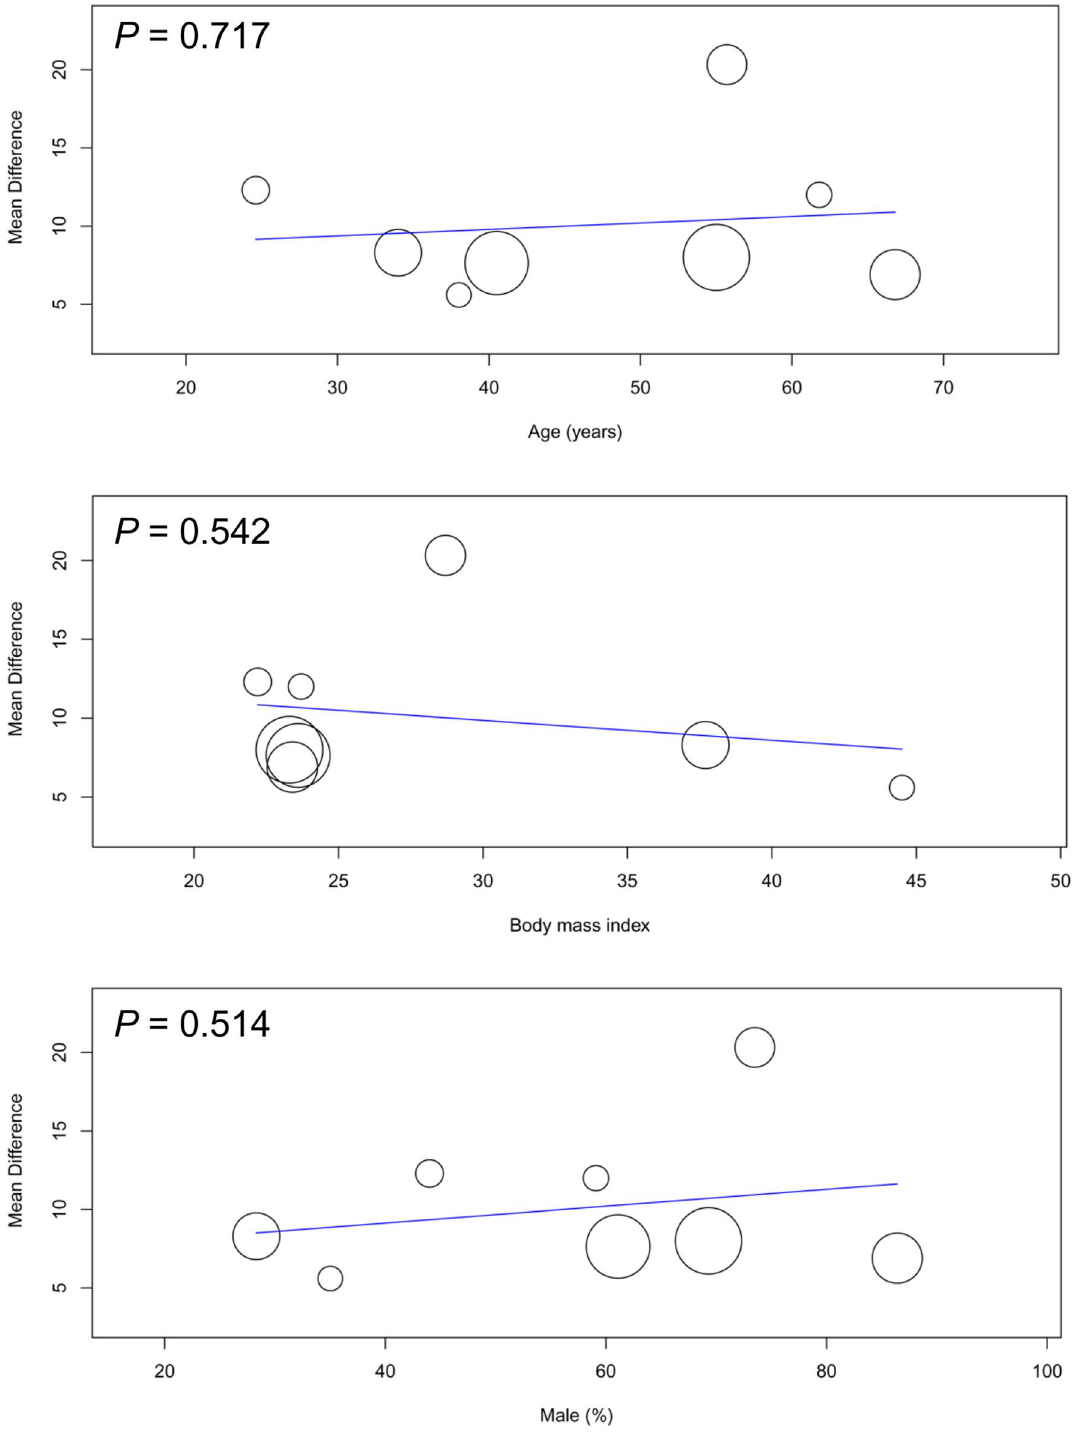
Figure 7. Meta-regression plot showing the association of patient characteristics (i.e., age, prevalence of male gender, and body mass index) with the mean difference in cuff